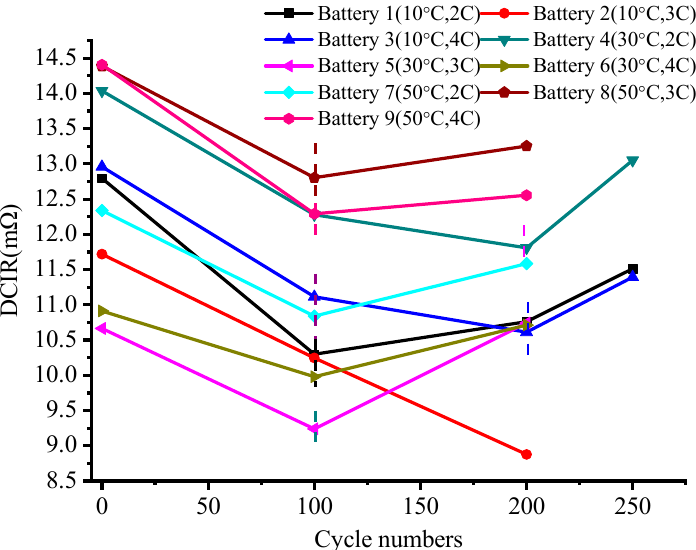
Figure 7. Changes in the DCIR with different aging paths.